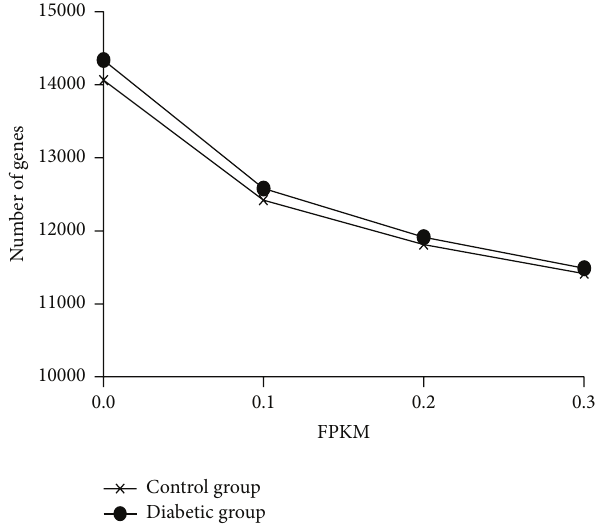
Figure 4: Number of expressed genes with different minimum expression thresholds.